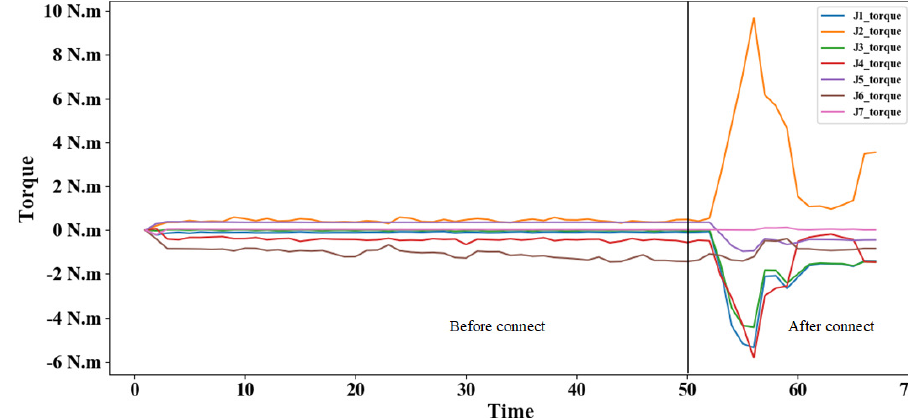
Figure 14. The torque of seven joints during assembly.